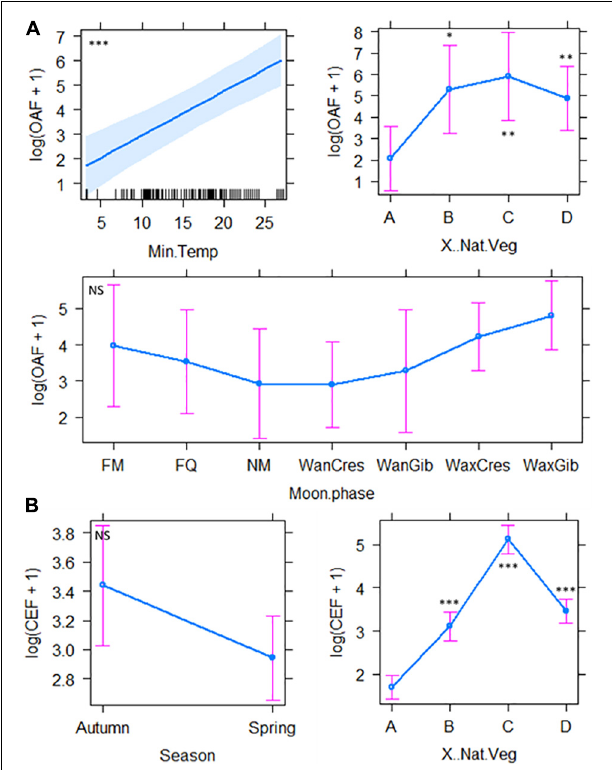
FIGURE 4 | The best fit model outputs indicating the factors responsible for the observed pattern of activity of open-air foragers (A) and clutter-edge foragers (B) . Bat detector and date were set as the random factors. A = 0%, B = 25%, C = 50%, and D = 100%. FM, full moon; FQ, first quarter; NM, new moon; WanCres, waning crescent; WanGib, waning gibbous; WaxCres, waxing crescent; WaxGib, waxing gibbous. NS, Not